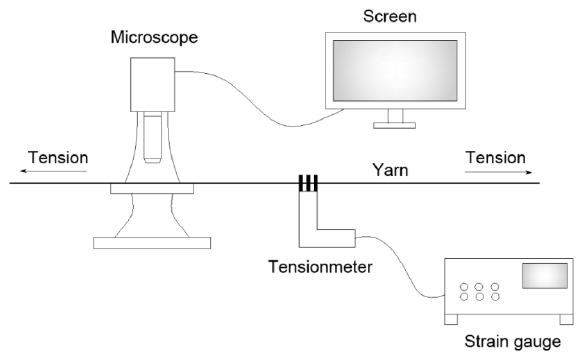
Figure 2. Schematic diagram of yarn diameter measurement setup.